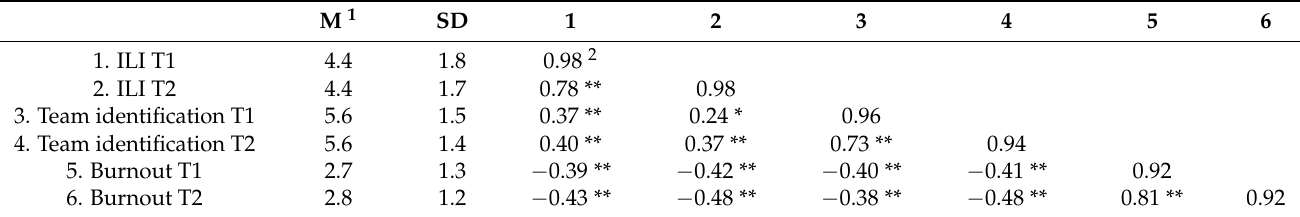
Table 3. Means, standard deviations and bivariate correlations between variables of the German sample at T1 and T2.